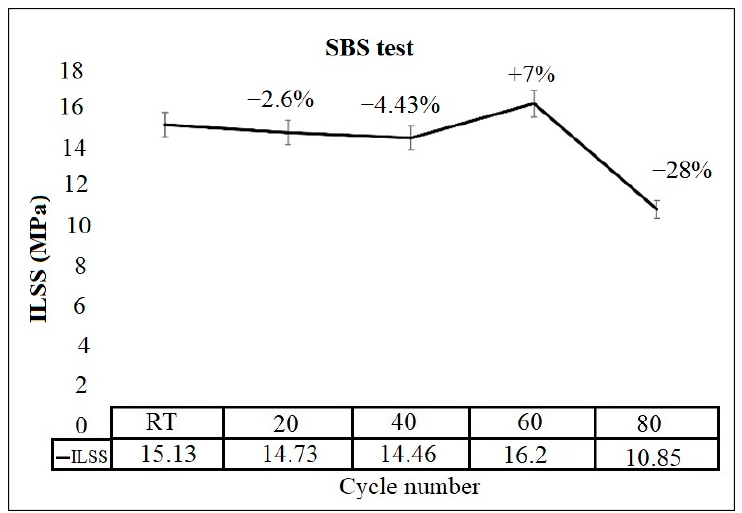
Figure 10. ILSS values of RT and thermal-cycling-exposure CFRP composites.